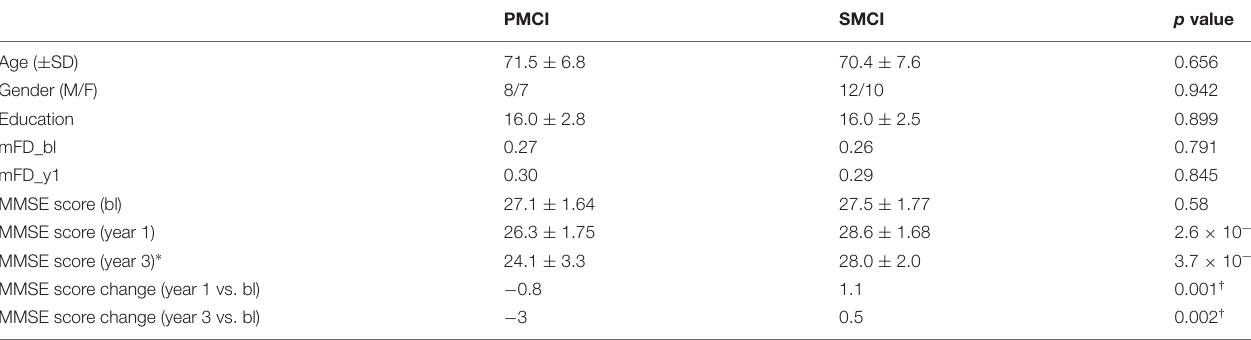
TABLE 1 | Demographics and Mini-Mental State Exam (MMSE) scores of subjects for longitudinal